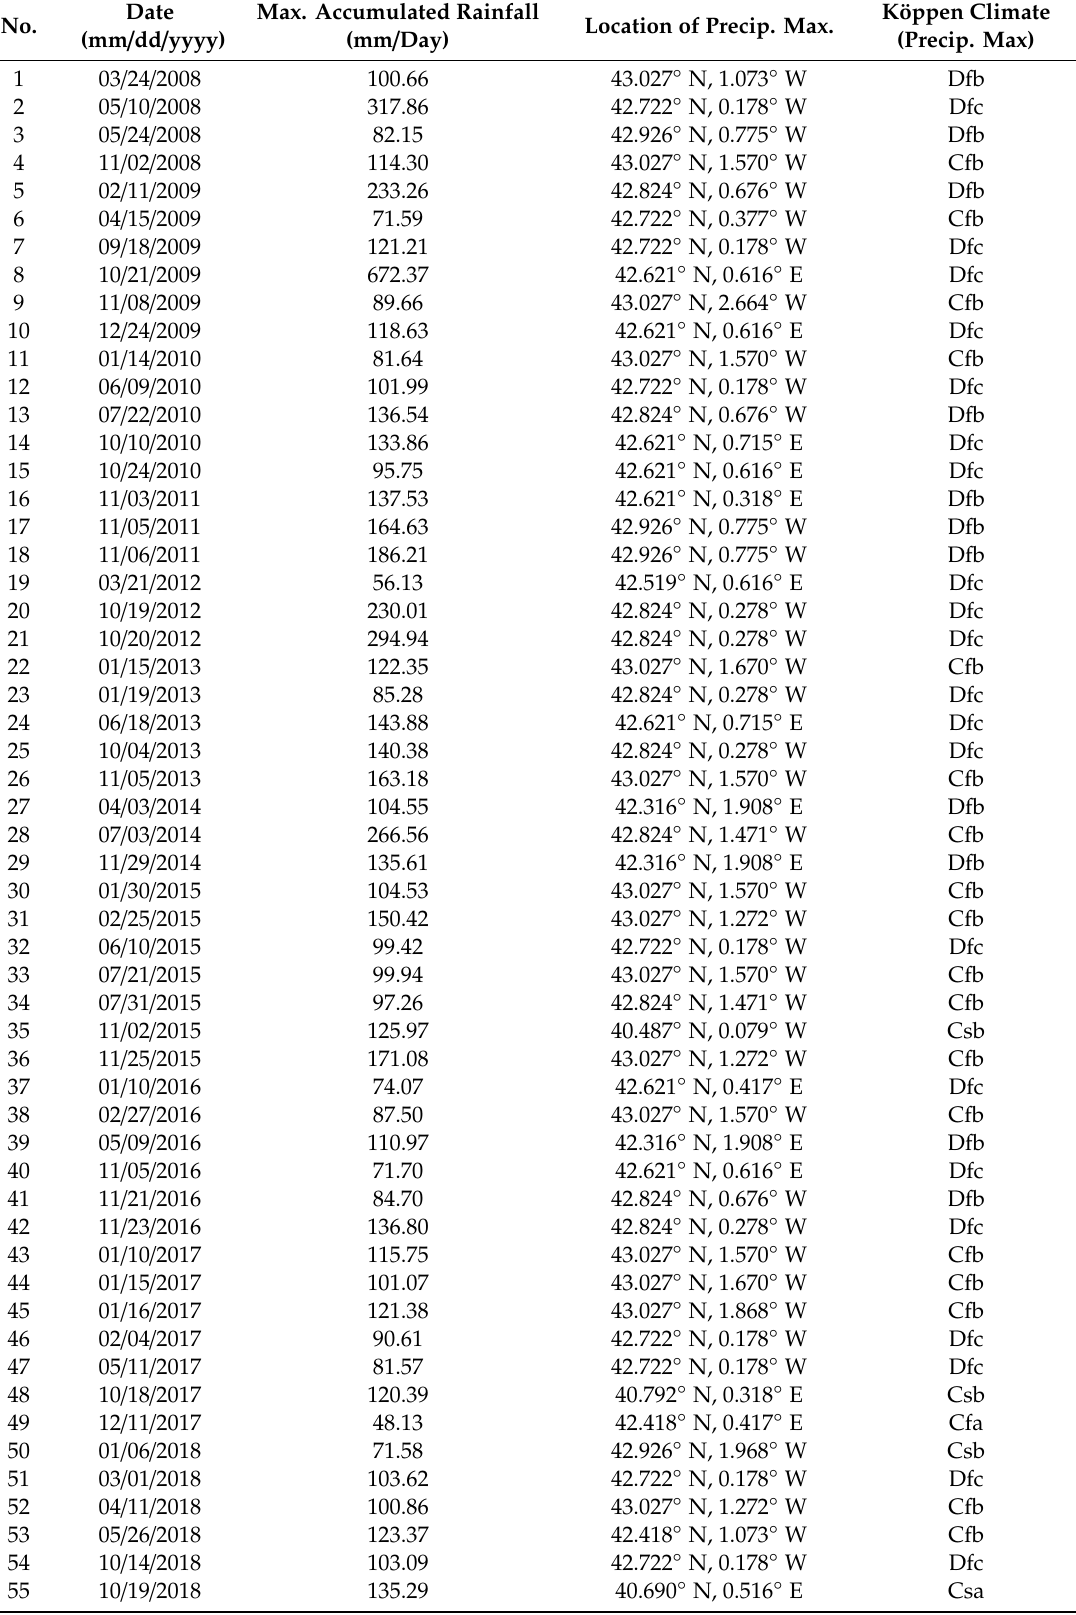
Table 3. List of cases with extreme rainfall (R99p) for the 2008–2018 period.